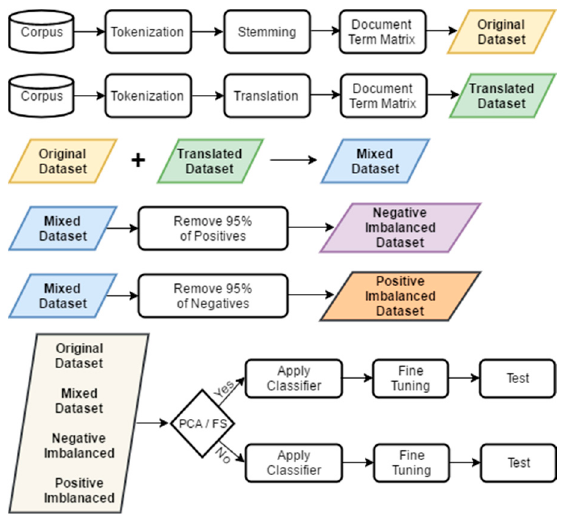
Figure 2. Methodology flowchart. FS, Feature Selection.